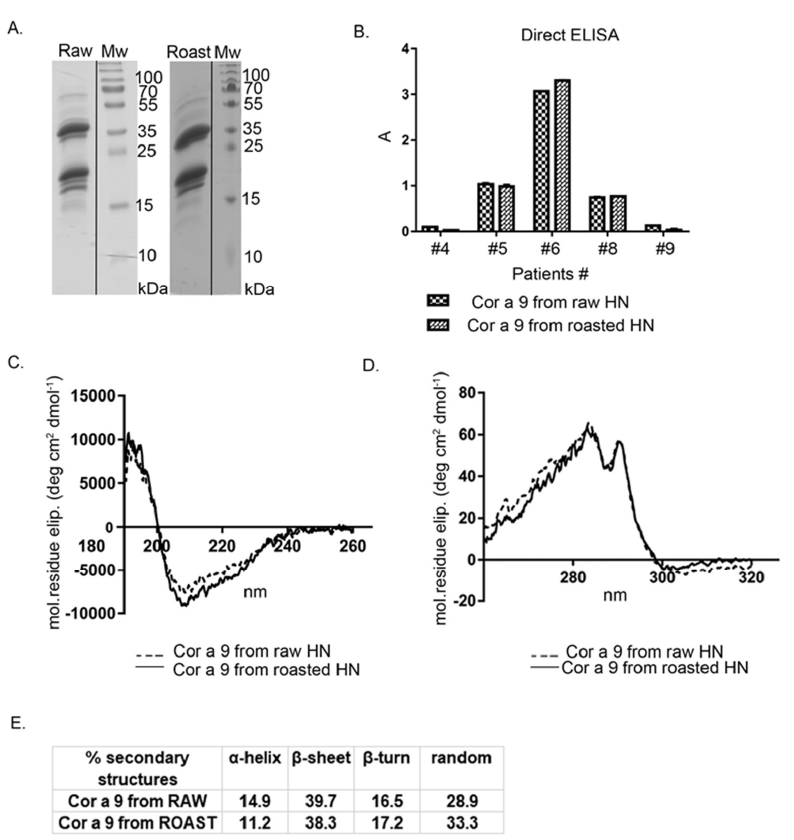
Figure 4. ( A ) 1D SDS-PAGE (14%) profile of Cor a 9 obtained from raw and roasted hazelnuts, isolated under the same reducing experimental conditions. Mw—molecular weight markers; ( B ) comparison of FAR-UV CD spectra of purified Cor a 9 obtained from raw and roasted hazelnuts; ( C ) comparison of the secondary structure of purified Cor a 9 obtained from raw and roasted ha- zelnuts; ( D ) comparison of Near-UV CD spectra of purified Cor a 9 obtained from raw and roasted hazelnuts; ( E ) IgE binding from individual sera of five hazelnut-allergic patients, with the raw and roasted hazelnuts, as revealed by IgE ELISA. A is the absorbance at 405 nm; HN—hazelnut . An intense protein band at ~40 kDa, with an accompanying band at 34 kDa, corre- sponded to an acidic subunit, while bands between 20–23 kDa were associated with basic polypeptide chains of the Cor a 9 protein (Figure 4A). This is in agreement with the elec- trophoretic band patterns of Cor a 9 purified with different buffer systems [25,26]. Up to three minor groups of light polypeptides were also detected, at masses of 19, 18, and 15 kDa. These low-mass peptides probably represent the products of partial hydrolysis of Cor a 9 [24]. The protein profile of Cor a 9 obtained from roasted hazelnut extract pos- sessed one additional faint band around 15 kDa, absent in the corresponding area of the raw hazelnut SDS-PAGE profile (Figure 4A). Only a few papers have reported on the evaluation of thermal processing effects on hazelnut proteins, and most considered Cor a 9 as thermostable [7,37]. Circular dichroism spectroscopy was applied to assess whether roasting treatment influenced Cor a 9 folding, compared with Cor a 9 obtained from the raw hazelnut. Ac- cording to our preliminary immunochemical studies, purified Cor a 9 from roasted ha-